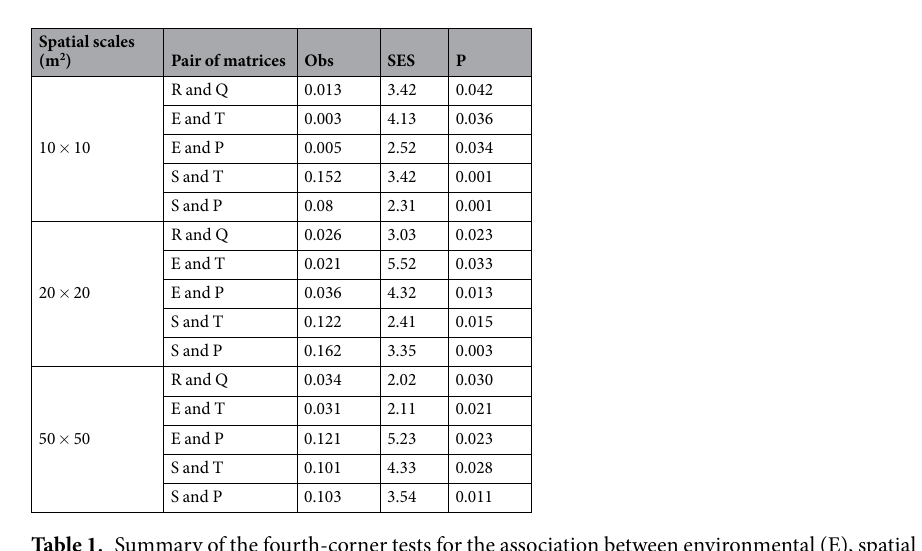
Table 1. Summary of the fourth-corner tests for the association between environmental (E), spatial (S), trait (T) and phylogenetic (P) matrices at different spatial scales. Obs, observed value; SES, standardized effect